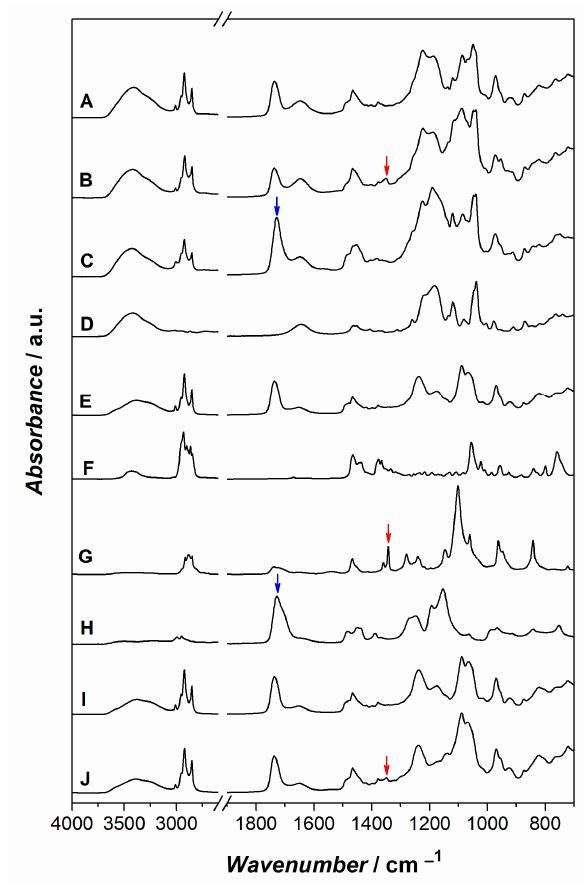
Figure 2. ATR-FTIR spectra of Type 1 liposomes ( A ), Type 2 liposomes ( B ), Type 3 liposomes ( C ), MES buffer ( D ), LS100 ( E ), Chol ( F ), DSPE-PEG-2000 ( G ), EuS100 ( H ), LS100/chol mixture 9:1 ( I ), LS100/chol/DSPE-PEG-2000 mixture 83:10:7 ( J ). See Materials and Methods for details on spectra acquisition. Arrows point out marker signals for DSPE-PEG-2000 (red) and EuS100 (blue).